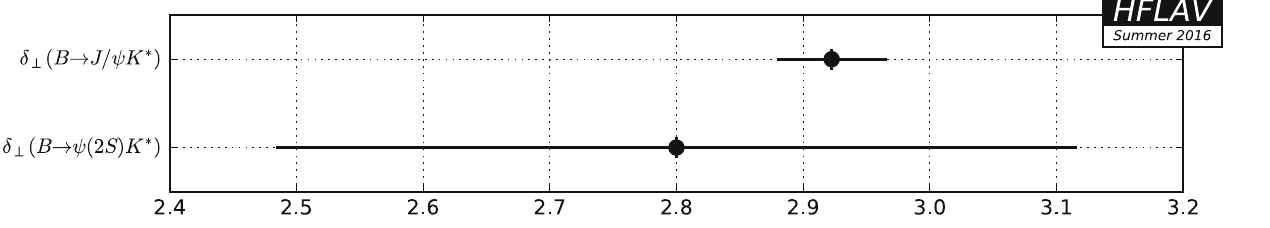
Fig. 150 Summary of the averages from Table